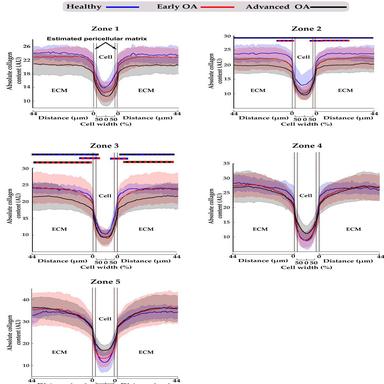
Collagen content profiles of the chondrocyte microenvironment at different tissue depths in the healthy, early OA and advanced OA groups. The lines represent averaged profiles and the shaded regions represent standard deviations within each group. The colored dash lines above the images indicate a statistically significant difference between the groups of those colors (p < 0.05). The average (± standard deviation) PCM width was 3.0 ± 1.3 μm and the average chondrocyte width was 16.0 ± 1.3 μm.